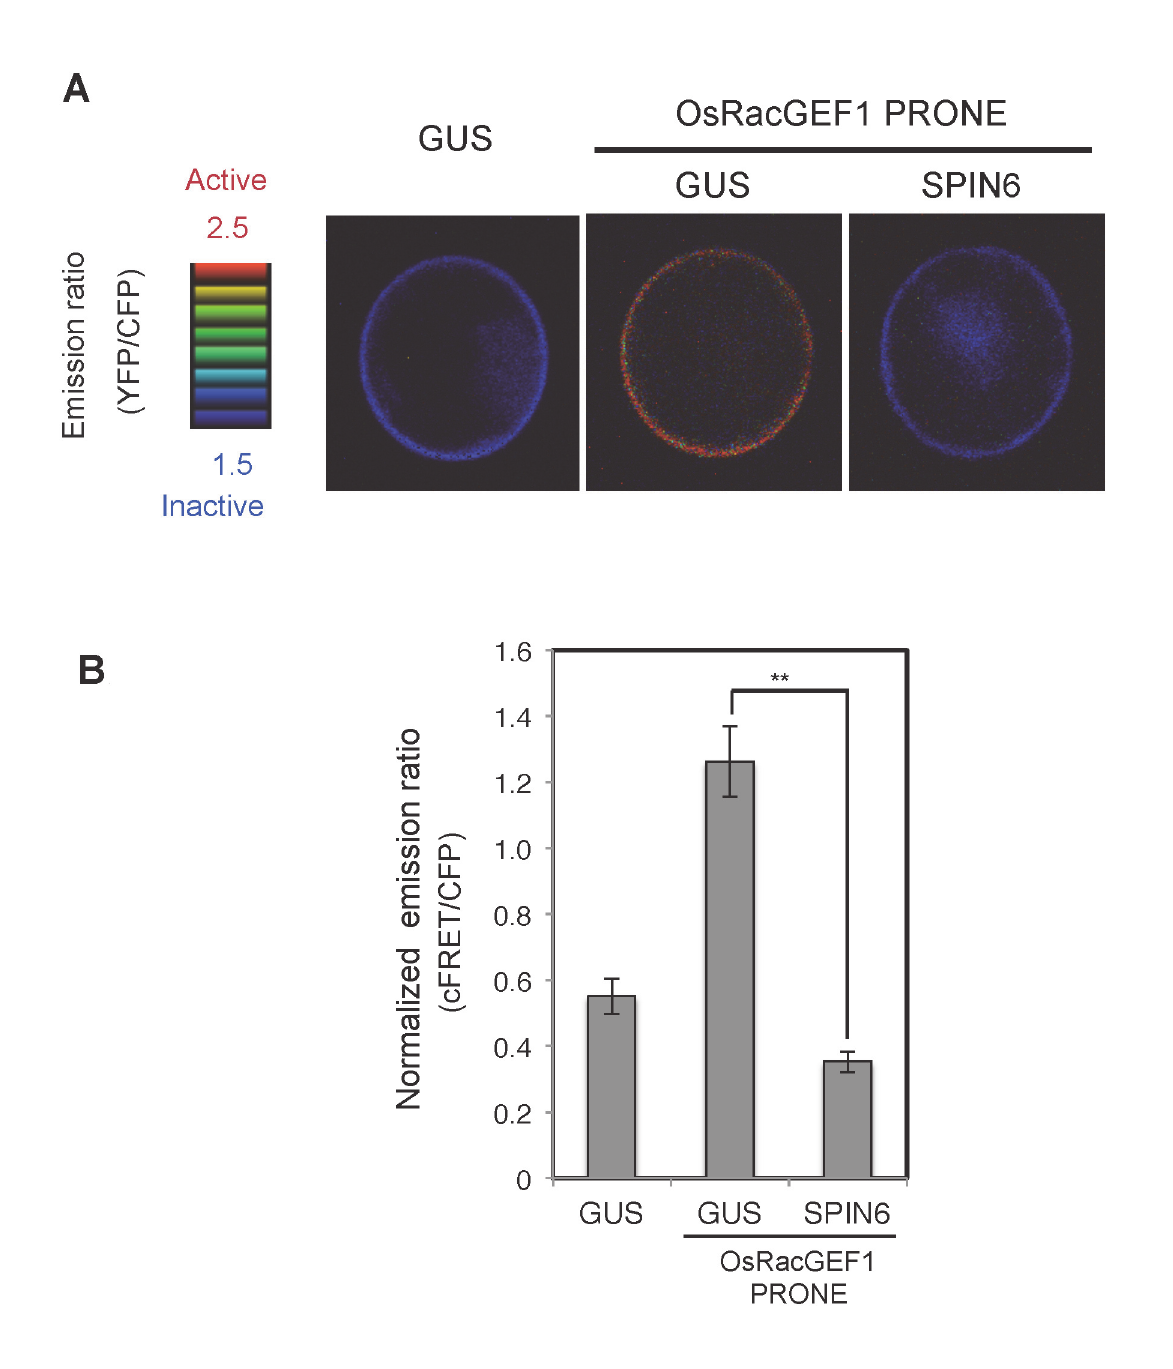
Figure 6. Analysis of RhoGAP activity of SPIN6 toward OsRac1 in rice protoplasts. (A) Images of confocal laser-scanning micrographs of rice protoplasts expressing the Raichu-OsRac1 constructs. Rice protoplasts were co-transfected with constructs expressing Raichu-OsRac1 and individual constructs. The FRET images are shown in intensity-modulated display mode, which associates color hue with emission ratio values and the intensity of each hue with the brightness of the source image. (B) Normalized emission ratio of cFRET/CFP. Double asterisks indicate significant differences (P < 0.01). Error bars indicate SE (N ≧